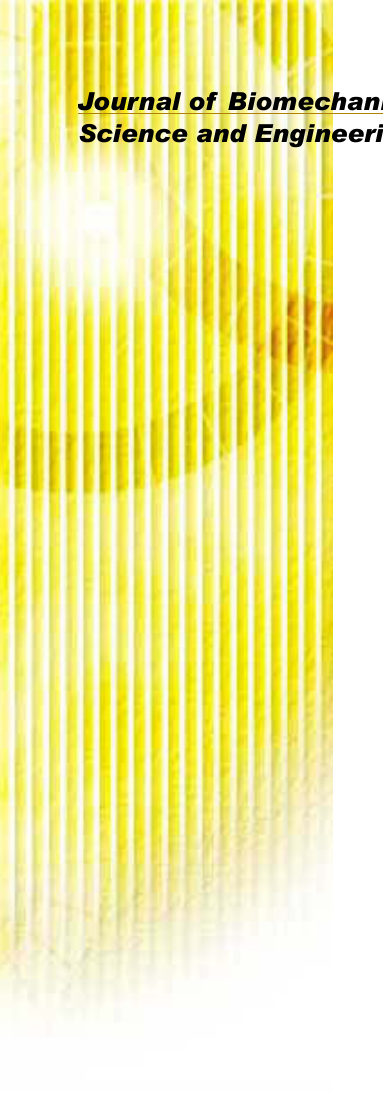
Fig. 3 High-probability (HP) arrangement patterns in the Hlg pore on the basis of S1 and S7 A. The top three subunits located at “adjacent” and “opposite” positions at high-probability are applied to the corresponding positions of the model when S1 is the basic subunit. The subunit located at high-probability is referred to Table 1 (marked with asterisks). In these models, the patterns in which the subunits located at “other” can be adapted to the position of high-probability in Table 2 are enclosed by squares and shown in bold, and especially termed limited HP (LHP). B. All models were created in the same way as in Fig. 3A on the basis of S7 instead of S1. The dashed lines in the figure mean partitioning between the groups of Dc1-Dc3 (or Dc1-Dc4) and Dc4-Dc7 (or